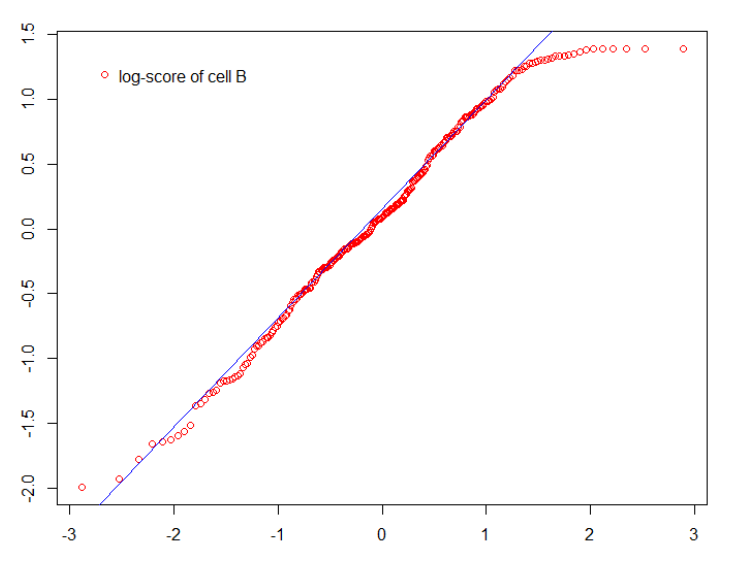
Figure 7. log-QQplot for cell B.